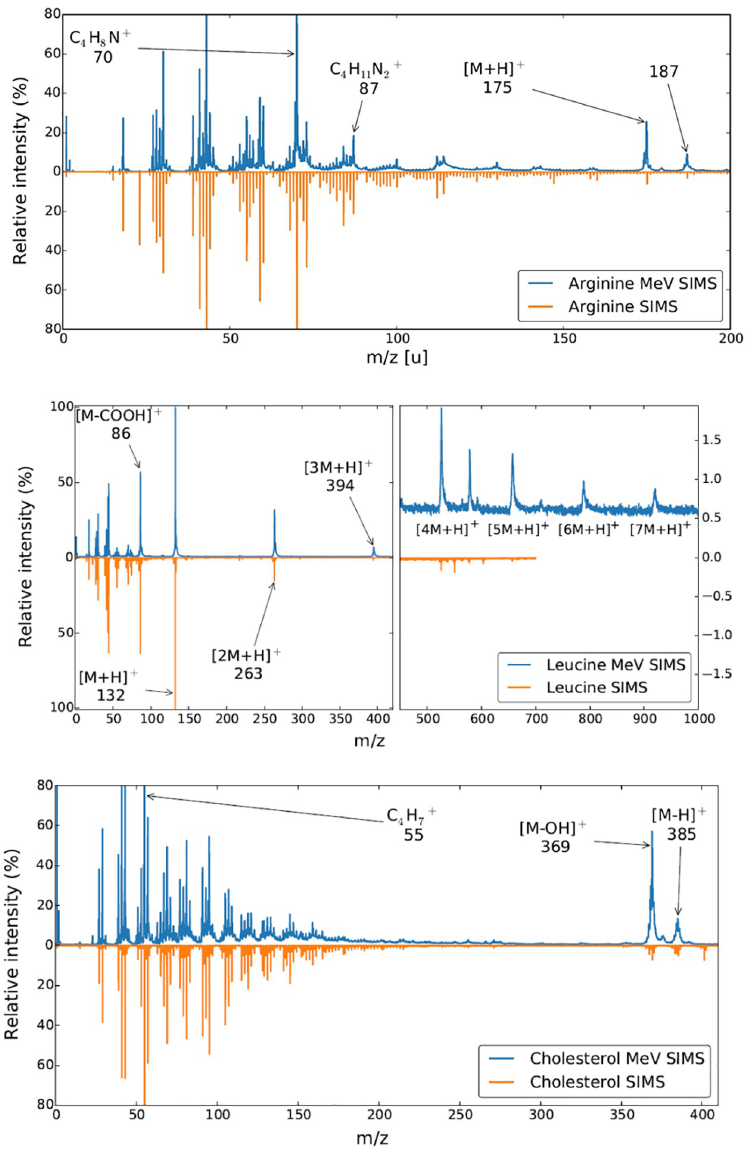
Fig 3. A qualitative comparison of 5.8 MeV 35 Cl 6+ MeV-SIMS ( blue ) and 25 keV Bi 3+ IONTOF TOF.SIMS 5 ( orange ) spectra of arginine, cholesterol and leucine used for calibration. The keV SIMS method does indeed offer better resolution, especially at lower energies, while MeV-SIMS gives higher yields for non-fragmented protonated